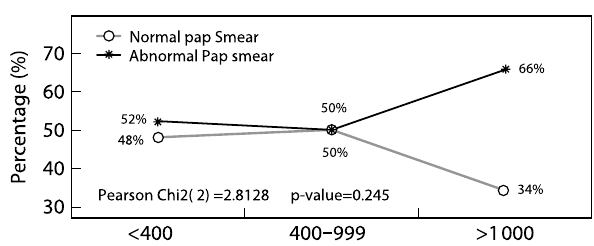
Figure 4: Association between viral load with abnormal Pap smears.